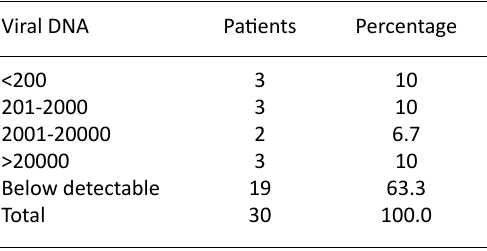
table 3. Viral DNA Load of Patients Viral